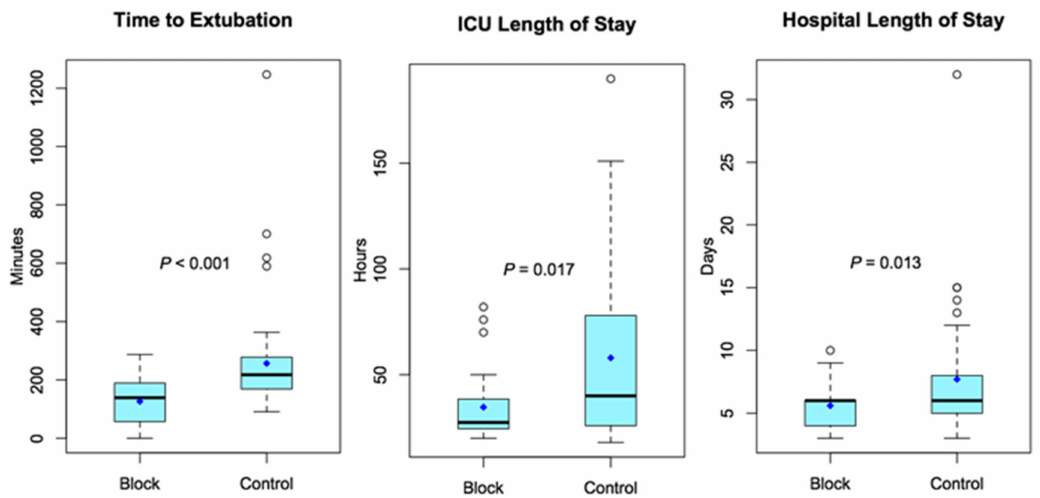
Figure 3. Box and whisker plots represent data as median values (bold horizontal line), interquartile range (box), interquartile range × 1.5 or furthest datum (dotted lines), and any outliers (open circles). Mean values are represented by blue